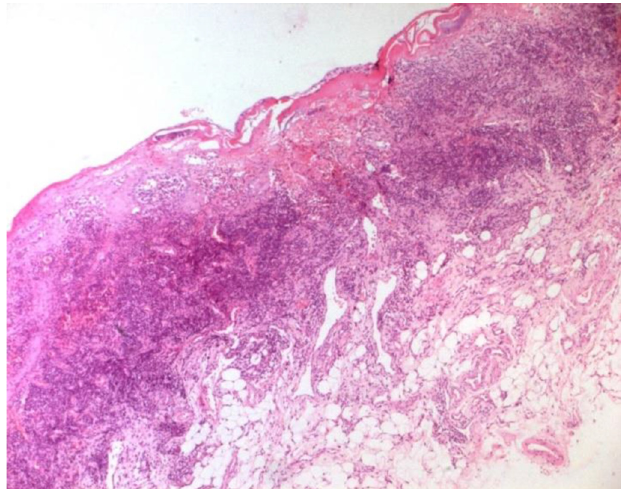
Fig. 5. HE*40: Apoptotic bodies in the epithelium, parakeratosis and a dense band-like lymphocytic in fi ltrate in the connective tissue with a degeneration of the basal